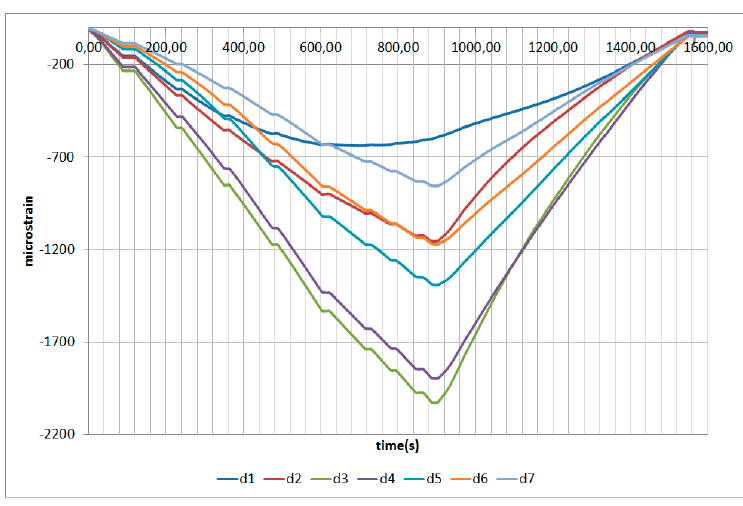
Figure 15. Specimen 1-Root joint -After fatigue -compression UL- Channel D.